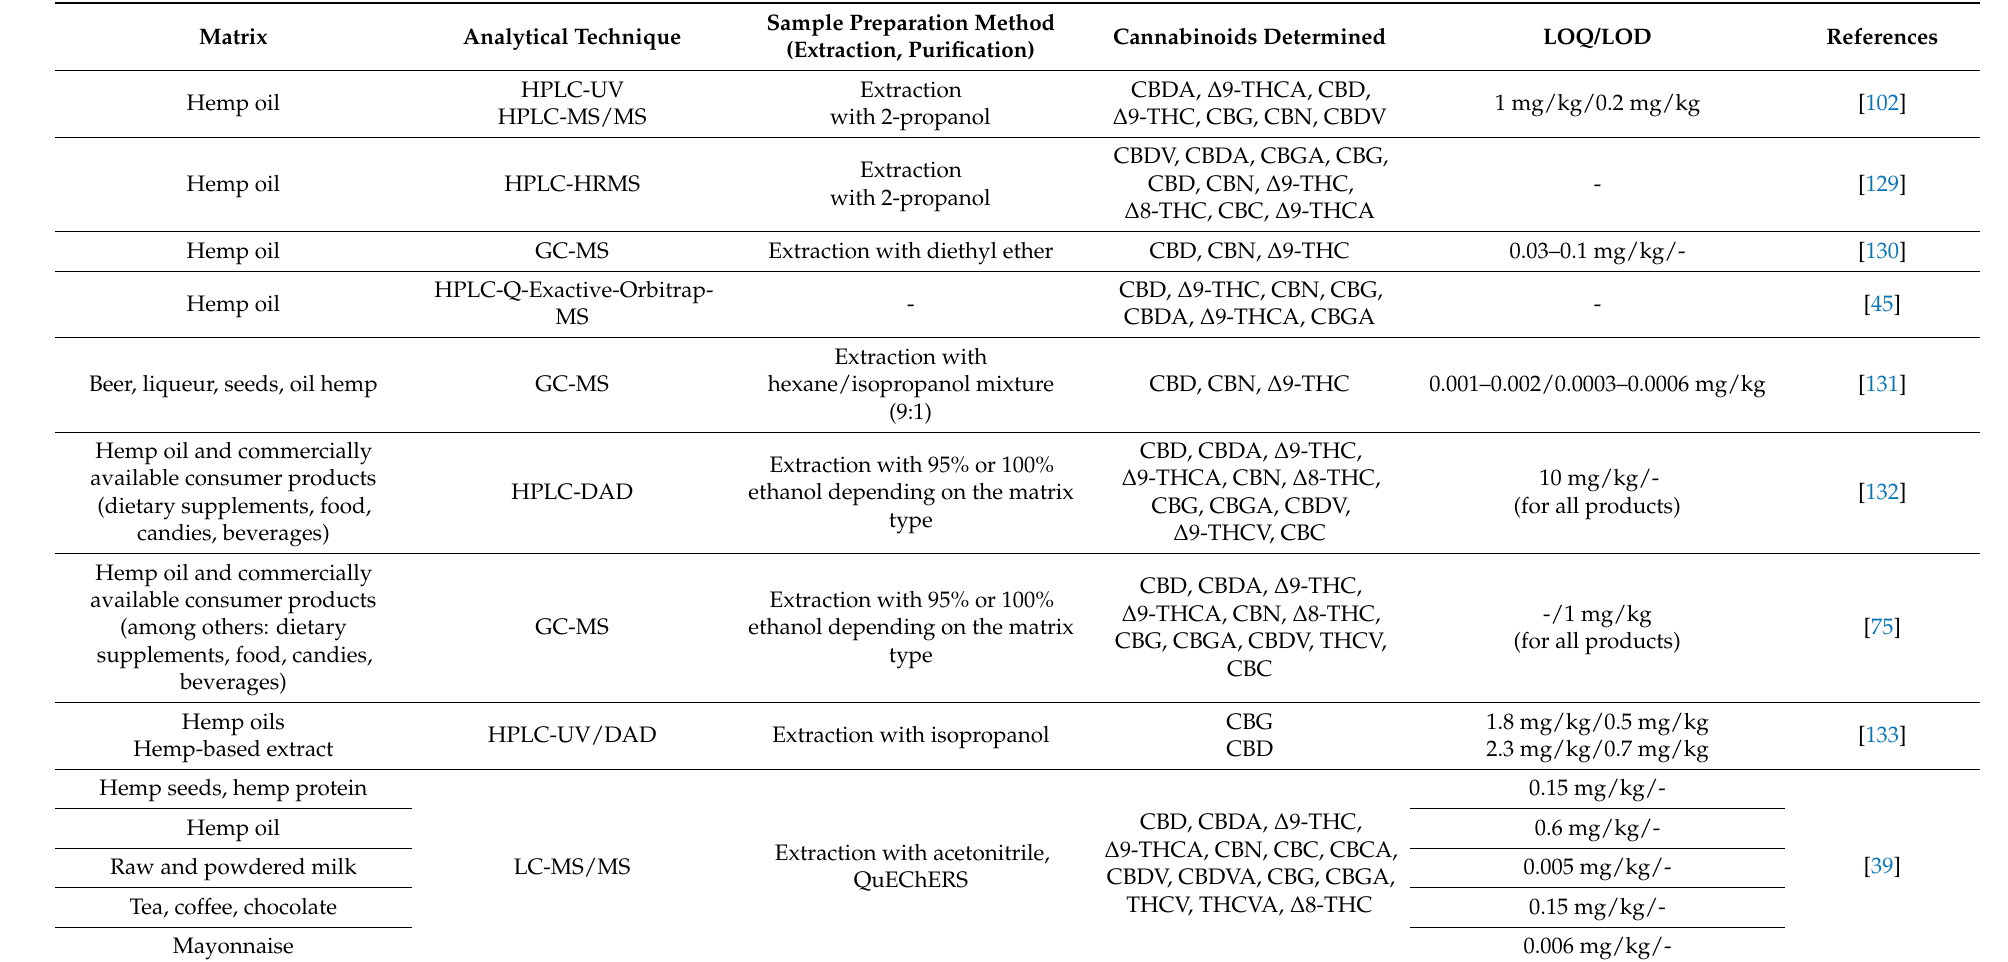
Table 4. Comparison of analytical methods for cannabinoids in food and